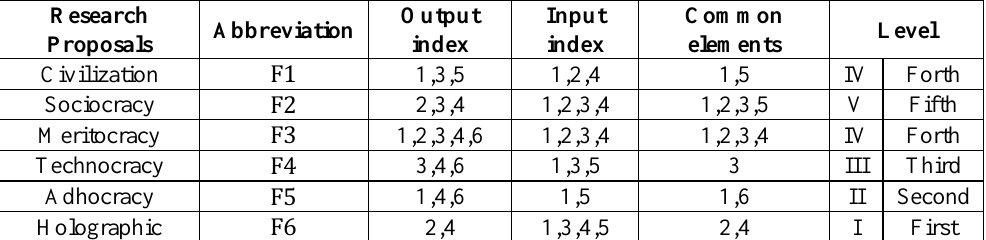
Table 16. a set of output indicators, inputs, and common elements of propositions